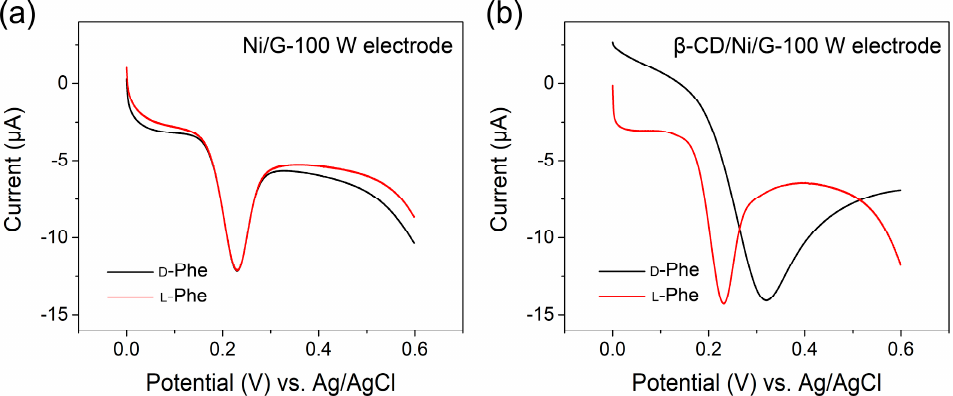
Figure 5. Di ff erential pulse voltammetry (DPV) curves of 1 µ M l -Phe and d -Phe at ( a ) Ni / G-100W and Figure 5. Differential pulse voltammetry (DPV) curves of 1 μ M L -Phe and D -Phe at ( a ) Ni/G-100W and ( b ) β -CD / Ni / G-100W. ( b ) β -CD/Ni/G-100W.